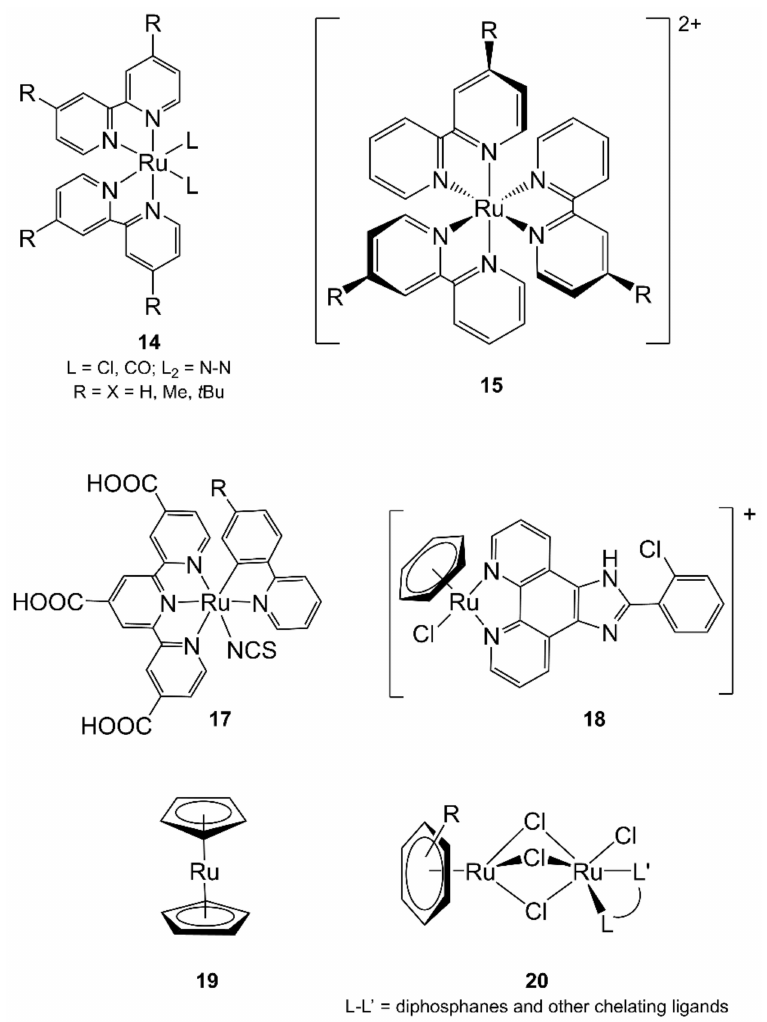
Figure 5. A selection of Ru complexes cited in the